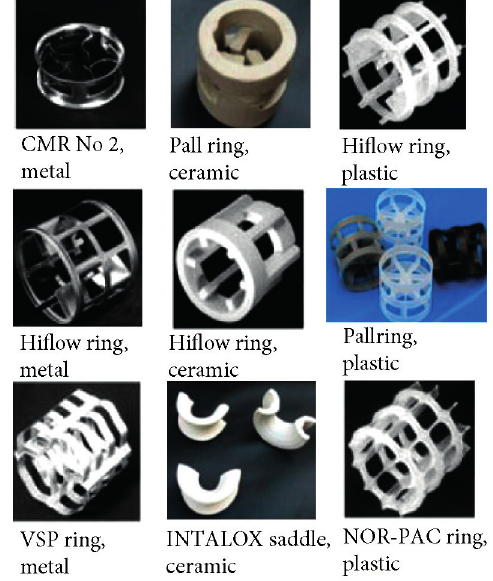
Table 5. Geometric characteristics of promising packing Fig. 4. Forms of the most commonly used industrial random